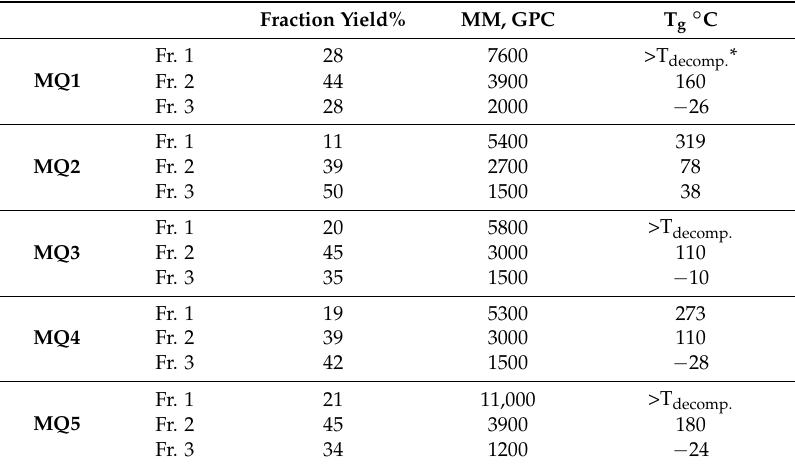
Table 2. Properties of variants of MQ copolymers.